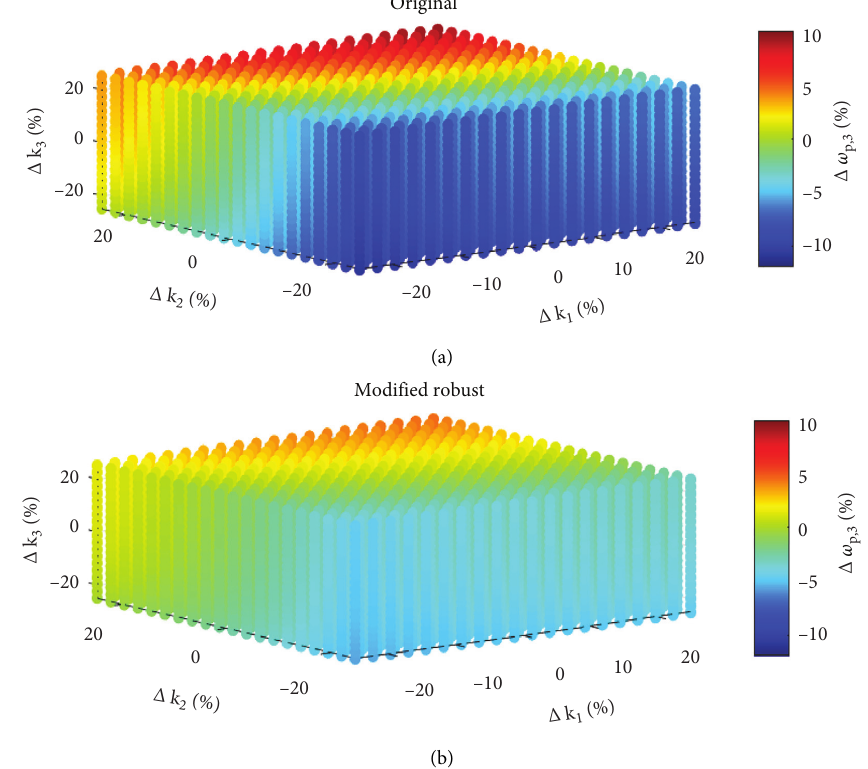
Figure 8: Test-case 3: percentage variation of the third natural frequency in the original and modified systems. Simultaneous perturbations of k 1 , k 2 , and k 3 . Table 13: Test-case 3: original and modified systems: percentage variation of the third natural frequency. Percentual variations (%) [ Δ k 1 ; Δ k 2 ; Δ k 3